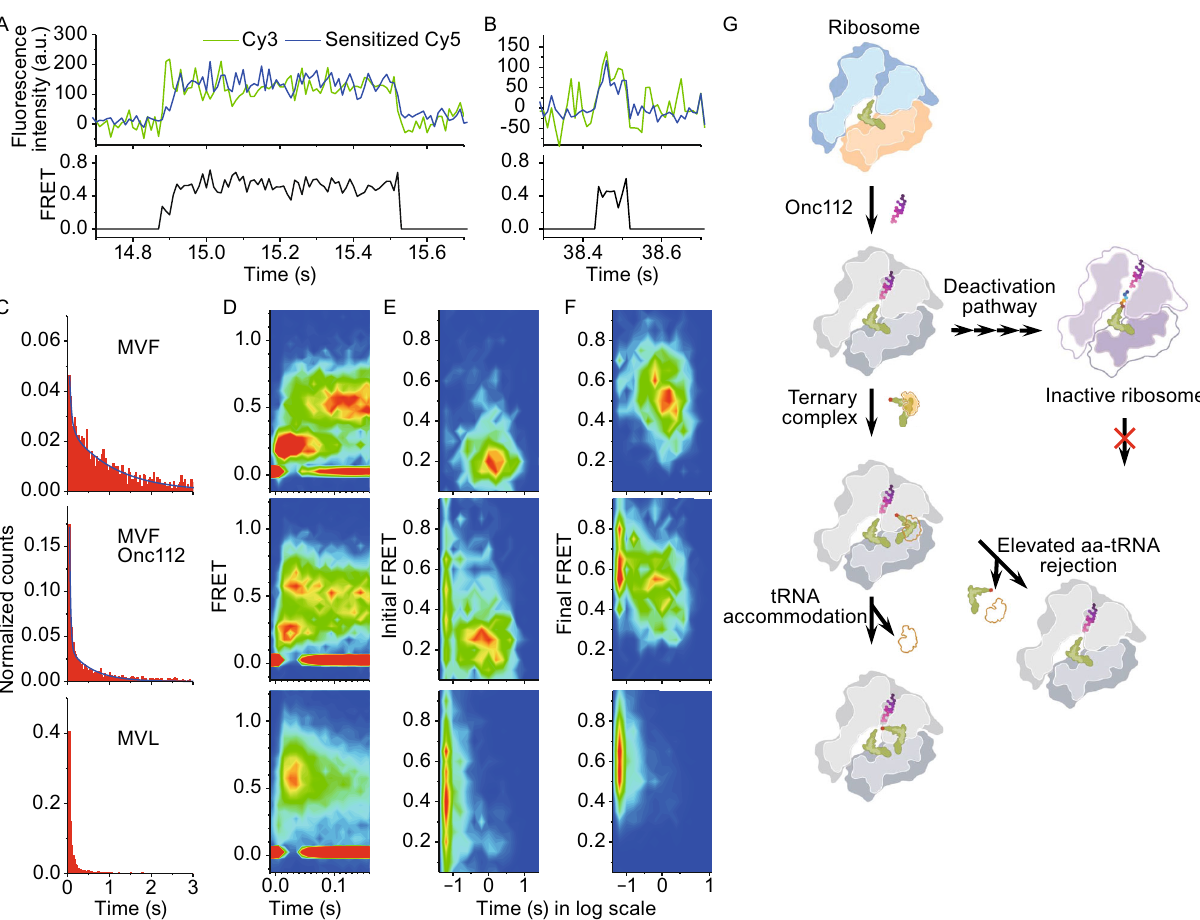
Figure 2. Onc112 inhibits aa-tRNA delivery and its proposed mechanisms . (A and B) Two types of typical real-time traces recorded while injecting 8 nmol/L Cy3-F ternary complex into fl ow channel, de fi ned as time t = 0, containing immobilized ribosomal POST-translocation complexes with Cy5-V in the P-site. Both long (A) and short (B) FRET events were captured using ribosomes programmed with mRNAs MVF or MVL, whose A-sites contain cognate or near-cognate codons for Cy3-F, respectively. Only Cy3 fl uorescence (green) and sensitized emission of Cy5 (FRET, blue) were collected under 532 nm laser excitation. (C) Dwell time distributions of all FRETevents captured using mRNA MVF without (top panel) or with (middle panel) Onc112, or mRNA MVL without Onc112 (bottom panel). Details of fi tting results were listed in Table S2. The same layout applies in (D – F). (D) FRET probability density plots as a function of time. All traces are aligned to the beginning of FRETevents as t = 0, when both Cy3 and FRETsignals appear simultaneously. (E and F) Heat maps constructed from initial FRET value when FRETevents appear (E) or fi nal FRET value right before FRET events disappear (F) vs. dwell times of FRET events. Each single-molecule event contributed as a single point in two-dimensional plots of FRET values vs. time. Heat maps were two-dimensional histograms made from all data points. Please notice that the top and bottom panels both contain one dominate population, whereas the middle panel has two populations. Number of events used here were listed in Table S2. (G) Proposed scheme to elucidate mechanisms of Onc112 in early elongation cycles. Two aspects have been highlighted. 1) Onc112 increases cognate aa-tRNA rejection rates, which leads to slower elongation rates. 2) Onc112 gradually deactivates 70% of ribosomes within 7 – 8 elongation